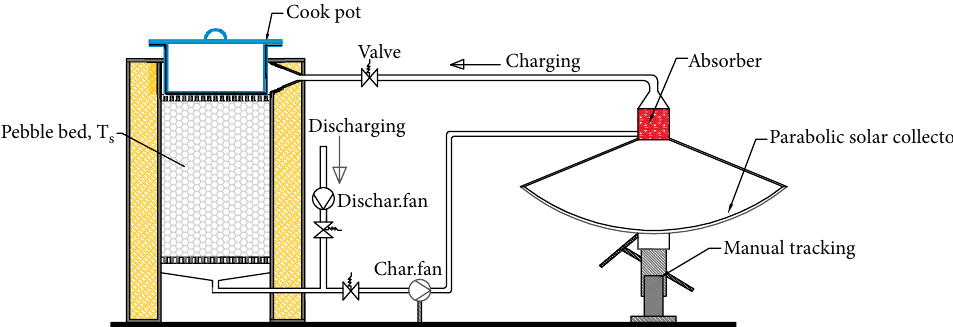
Figure 2: Schematic diagram of pebble bed thermal storage integrated with parabolic solar collector and cooking pot during discharging period.